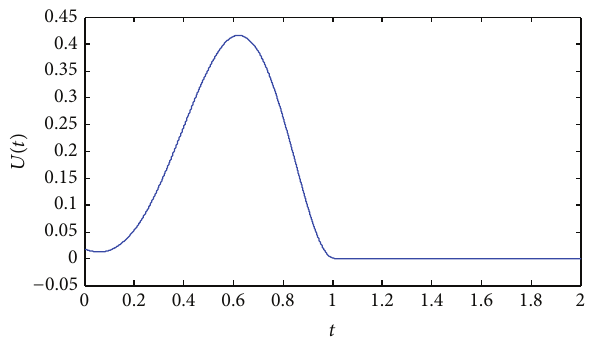
Figure 3: The temporal function 𝑈(𝑡) ( 𝛾 = 4.5 ).